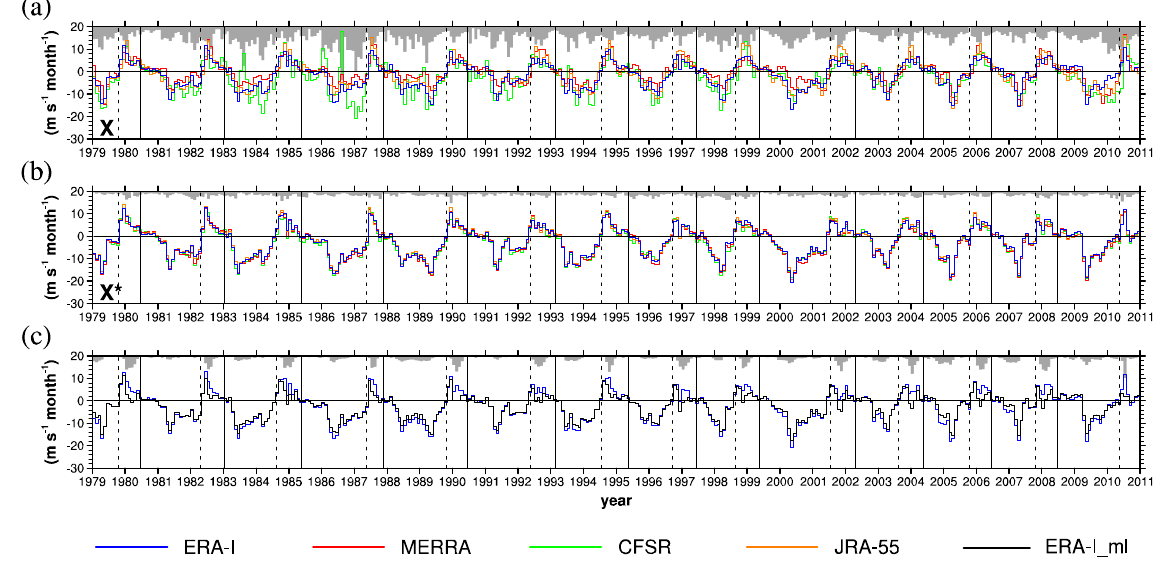
∗ ∗ , and (c) as in Fig. 3 for X (see the text for a definition of these terms).